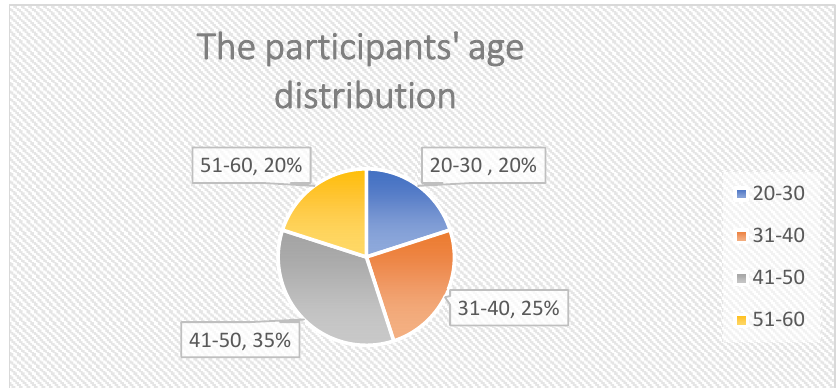
Figure 3. The participants’ age distribution.